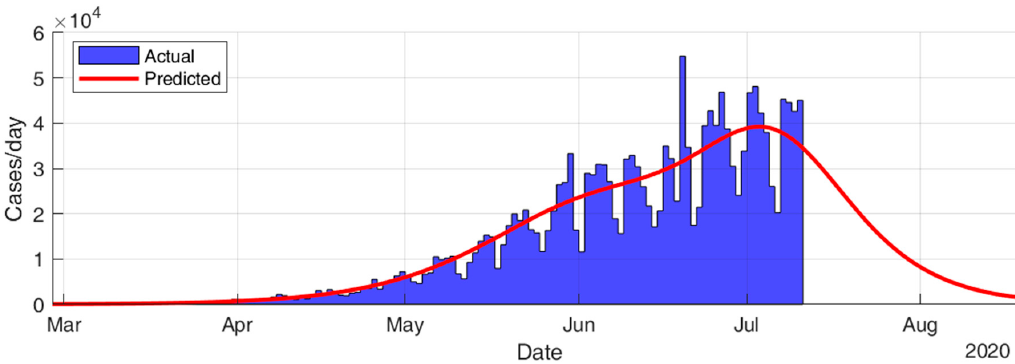
Figure 18. Prediction results for infection cases in USA.